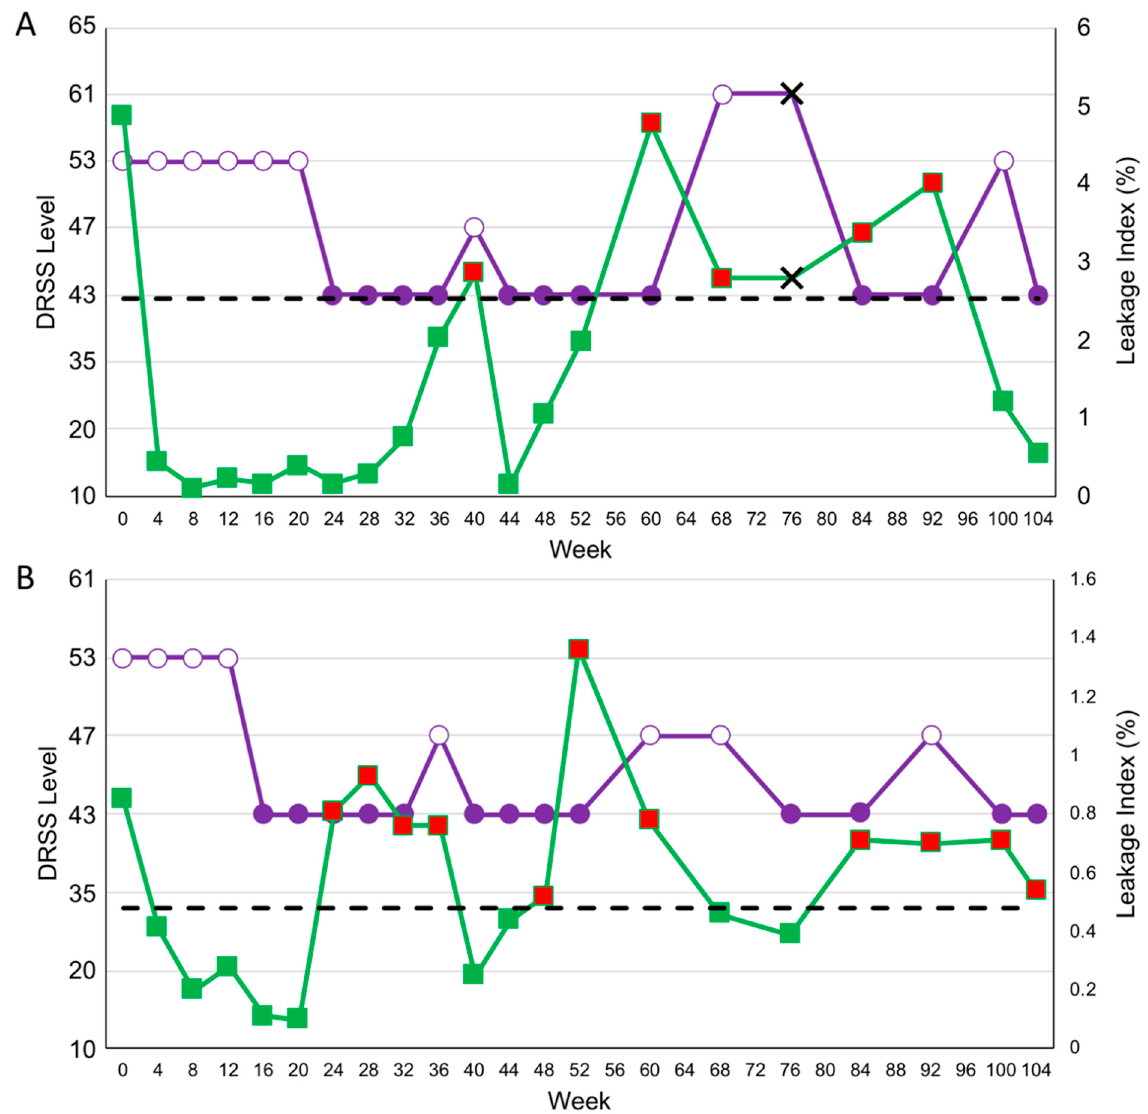
Figure 5. Subject cases from the diabetic retinopathy severity scale (DRSS)-guided arm through week 104. ( A ) Subject 23 and ( B ) subject 37 both demonstrated instances of ≥ 1-step DRSS worsening from the best-achieved DRSS, each of which was either preceded by or occurred alongside a meaningful panretinal leakage index (PLI) worsening. Purple indicates DRSS level; white-filled markers indicate a visit before the initial ≥ 2-step DRSS level improvement with initial monthly dosing or a visit with a DRSS worsening compared to best-achieved DRSS level; green indicates PLI level; red-filled markers indicate a worsening in PLI above the re-treatment level according to the PLI-guided protocol; black dotted lines indicate the re-treatment level as indicated by the PLI-guided protocol; black X markers indicate a missed visit.